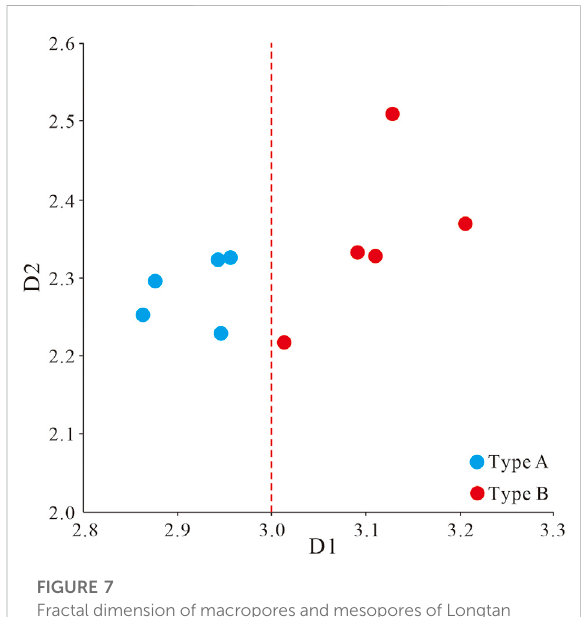
FIGURE 7 Fractal dimension of macropores and mesopores of Longtan shales.